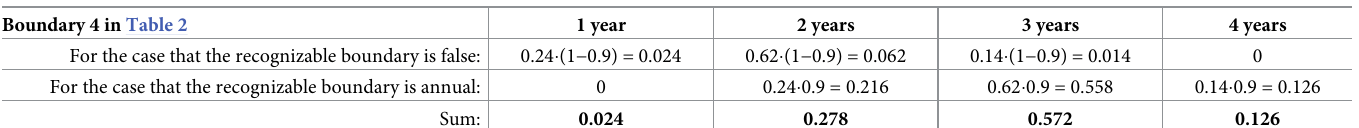
Table 4. Boundary 4 in Table